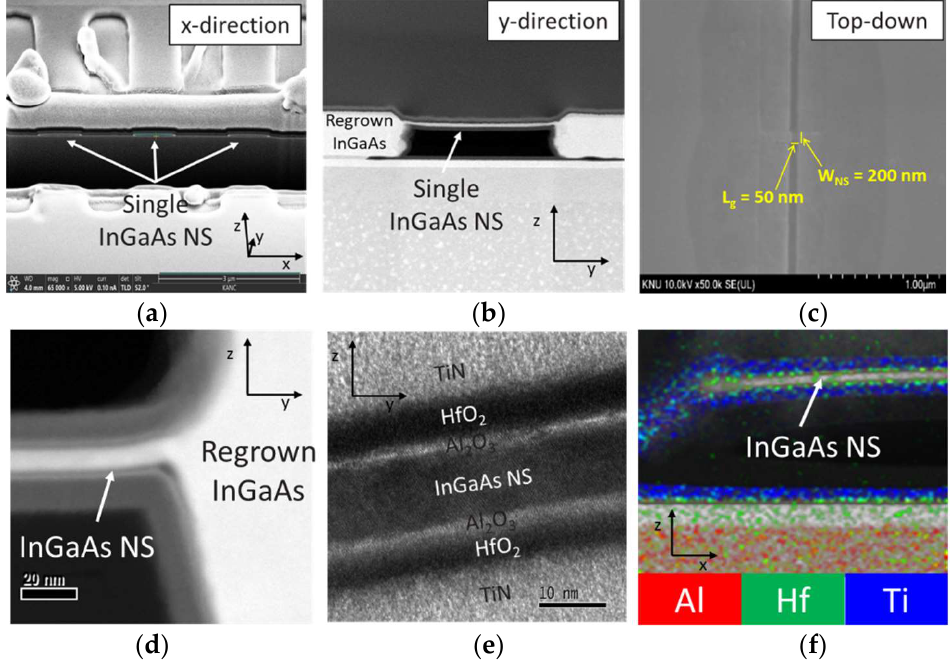
Figure 3. Cross-sectional and top-down TEM/SEM images of the fabricated GAA In 0.53 Ga 0.47 As NS MOSFETs along the W g ( x -direction, ( a )) and S/D ( y -direction, ( b – e )) directions, and EDS mapping data ( f ).